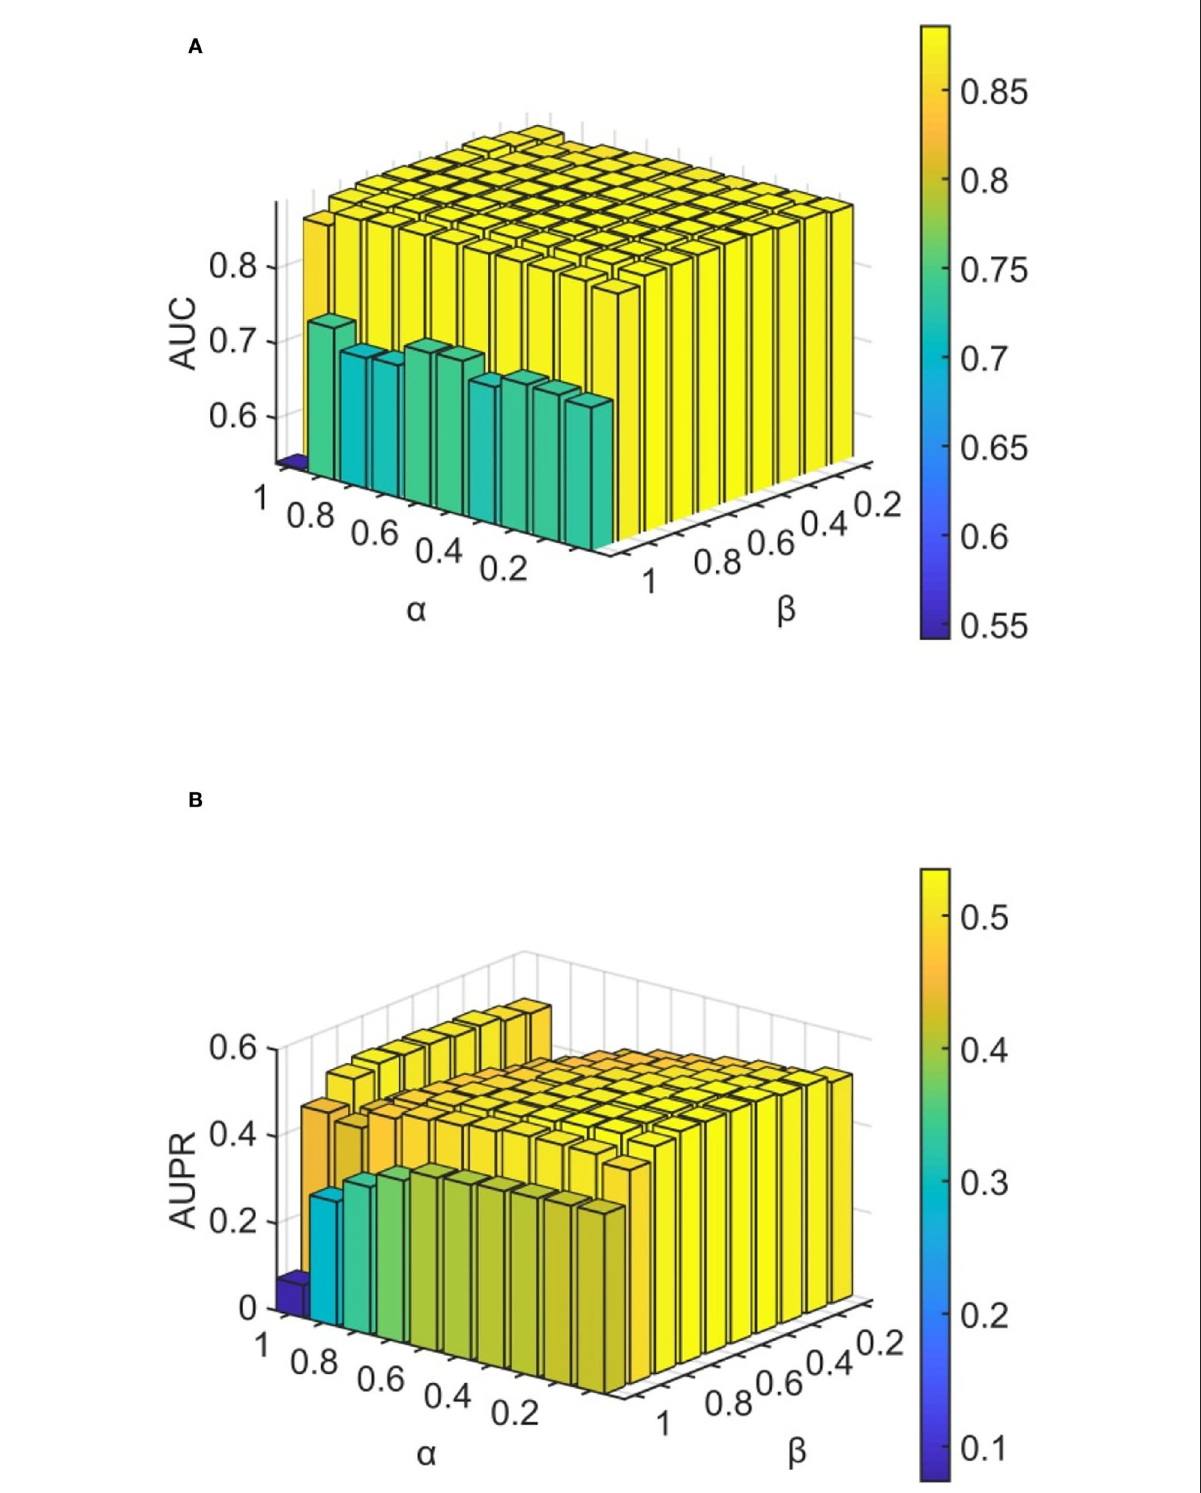
FIGURE5 Analytical plots of AUC and AUPR for α and β in the LP algorithm. (A) Analytical plots of AUC for α and β . (B) Analytical plots of AUPR for α and β